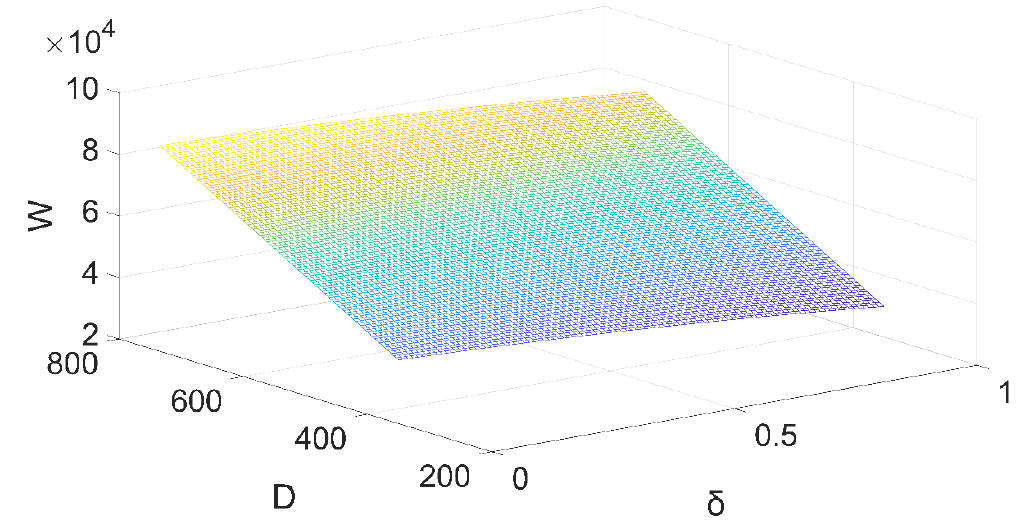
Figure 5. Total utility of healthcare supply chain network under the centralized decision.